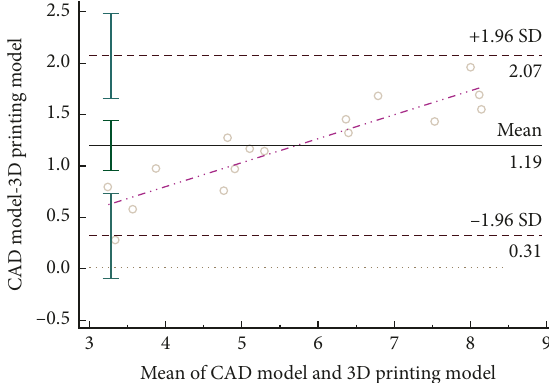
Figure 11: Bland–Altman plot for the 3D printing models and CAD